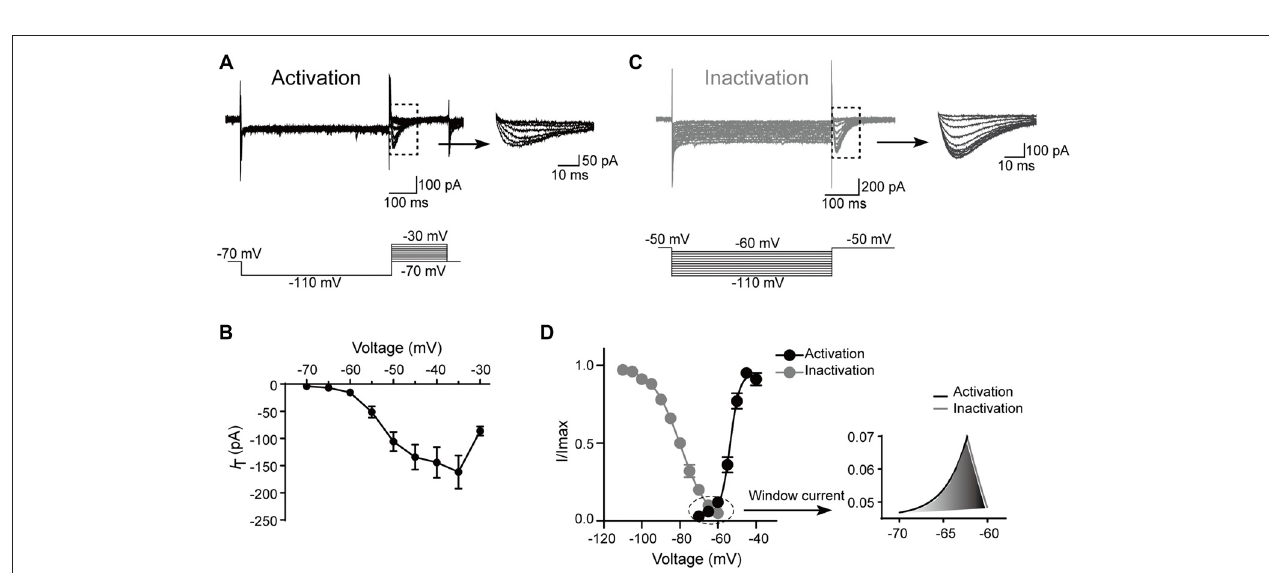
FIGURE 4 | Kinetic properties of T-type current in SG neurons. (A) Top left: traces represent families of T-type currents evoked in a representative SG neuron. Top right: enlargement of the T-type currents in the rectangle shown on the left. Bottom is the voltage-clamp protocol used to elicit currents. (B) Activation current-voltage relationship of the T-type current from the same neurons shown in panel (A) . (C) Top left: traces represent families of averaged T-type currents evoked in a SG neuron. Top right: enlargement of the T-type currents in the rectangle shown on the left. Bottom is the voltage-clamp protocol used to elicit currents. (D) The average T-type current activation and steady-state inactivation curves. Right panel is the enlargement of window current in the circle shown on the left. Activation curve was fitted with the following Boltzmann sigmoid equation: I / I max = 1/[1 + exp[( V 0.5 – V )/ k ]], in which I is the amplitude of current at step potential, I max represents the maximal current amplitude, V 0.5 is the midpoint potential, V is the membrane potential, and k is the slope factor. Inactivation curve was fitted with the following Boltzmann equation: I / I max = 1–1/[1 + exp[( V − V 0.5 )/ k ]], in which I is the amplitude of current at step potential, I max represents the maximal current amplitude, V 0.5 is the midpoint potential, V is the membrane potential, and k is the slope factor.